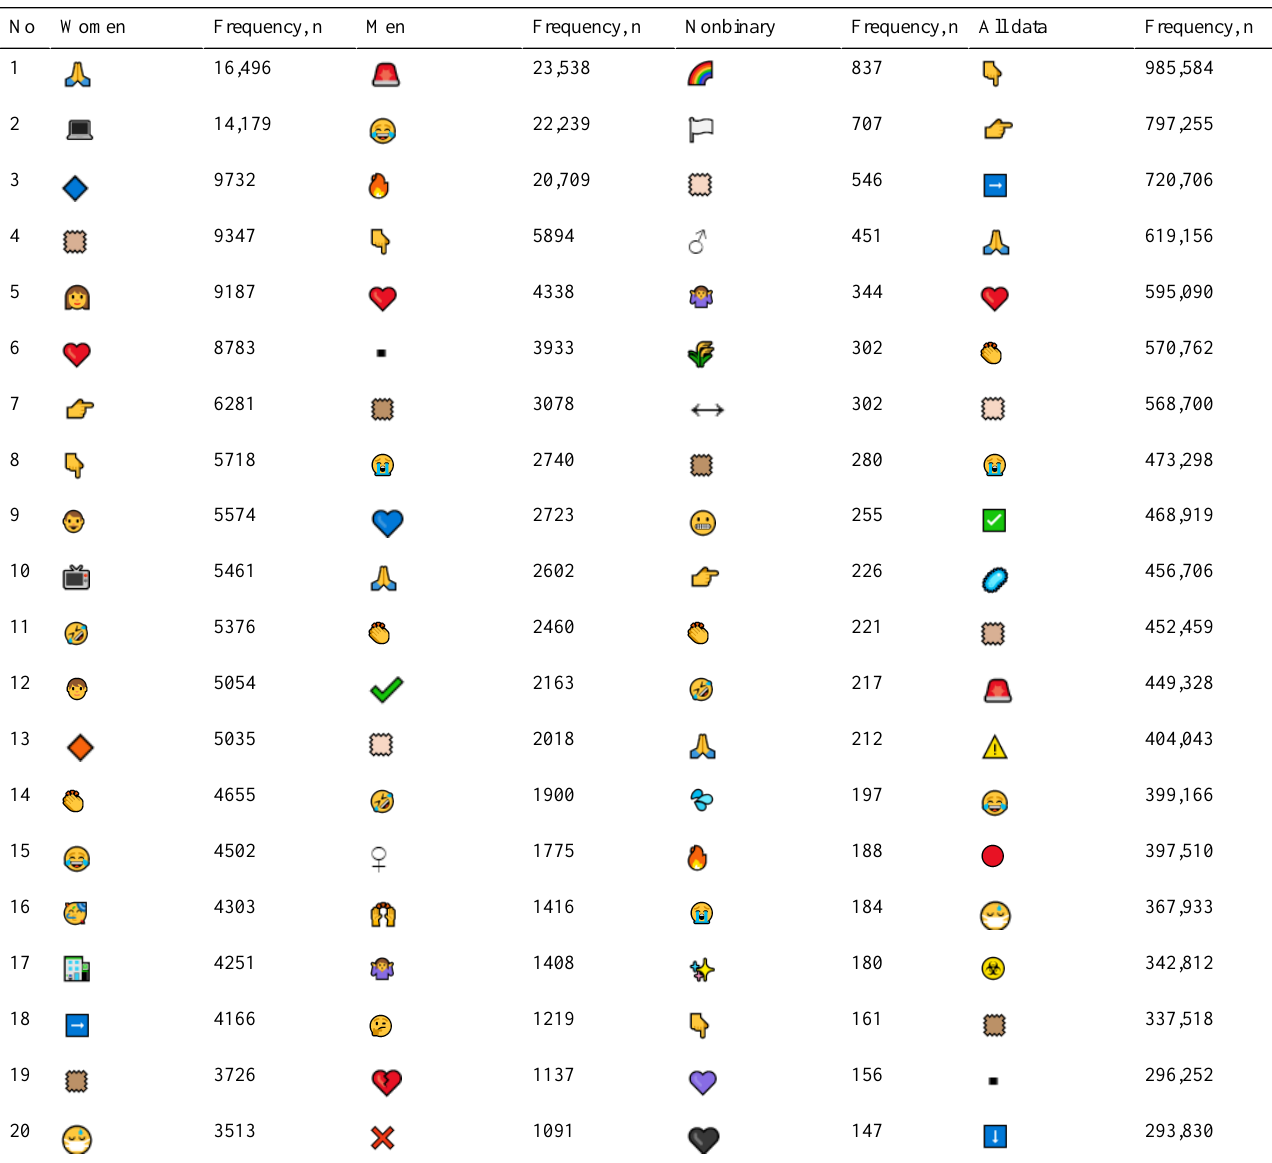
Table 1. The top 20 most frequent emojis along gender